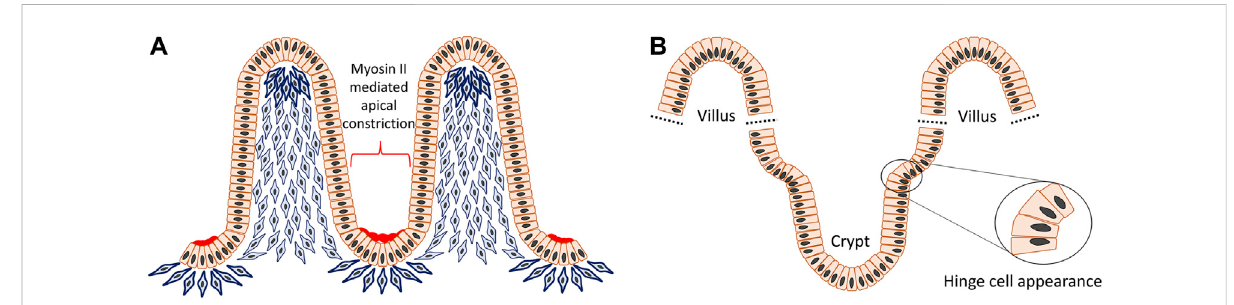
FIGURE 5 Reverse curve morphogenesis of crypt-villus structure in the intestine. The villi are evaginations toward the intestinal lumen and the crypts are invaginations between villi. In the beginning, mesenchymal cells underneath the fl at pseudostrati fi ed epithelium condense at intervals and then aggregate to move towards the lumen and support the super fi cial epithelium to protrude to form the tip of the villi. The villus height is increased by cell proliferation, however at the same time some epithelial cells undergoing mitosis, experience apical constriction with the accumulation of myosin II and actin and contribute to formation of the crypts (A) . Also, at the crypt-villus junction there is an interesting region formed by so called “ hinge cells ” that adopt a wedge shape through basal constriction (B)